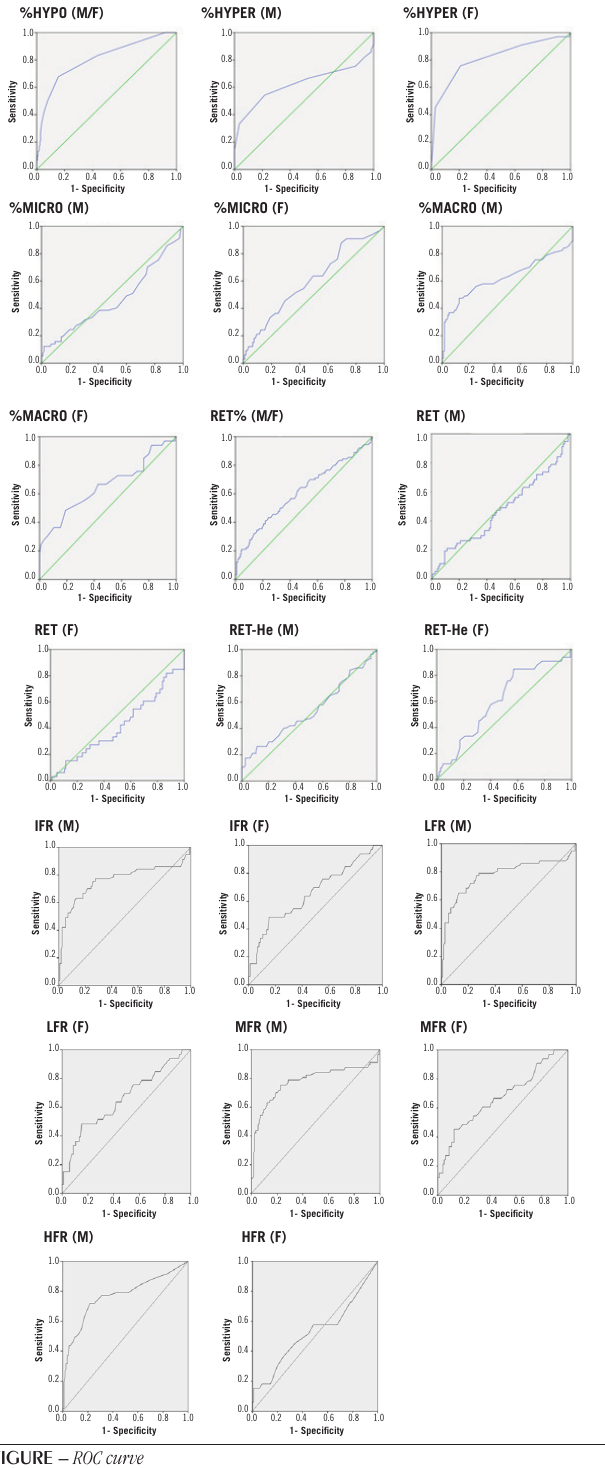
figuRE – ROC curve ROC: receiver operating characteristic curve; %HYPO: percentage of hypochromic red blood cells; M: male; F: female; %HYPER: percentage of hyperchromic red blood cells; %MICRO: percentage of microcytosis; %MACRO: percentage of macrocytosis; RET: absolute reticulocyte count; RET-He: reticulocyte hemoglobin content; IFR: immature reticulocyte fraction; LFR: low fluorescence reticulocytes; MFR: medium fluorescence reticulocytes; HFR: high fluorescence